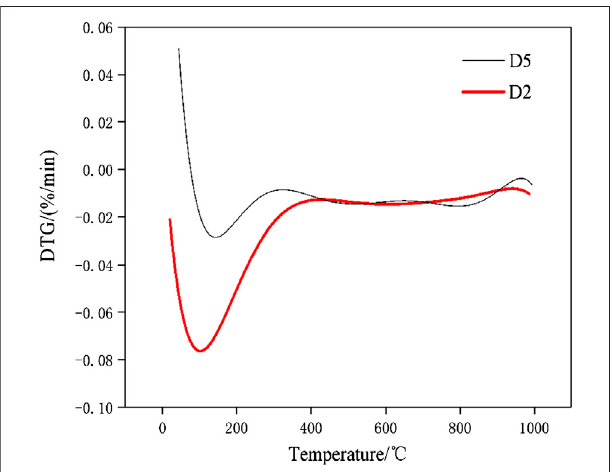
FIGURE 11 | XRD diffractogram of geopolymer specimens of D2 group.